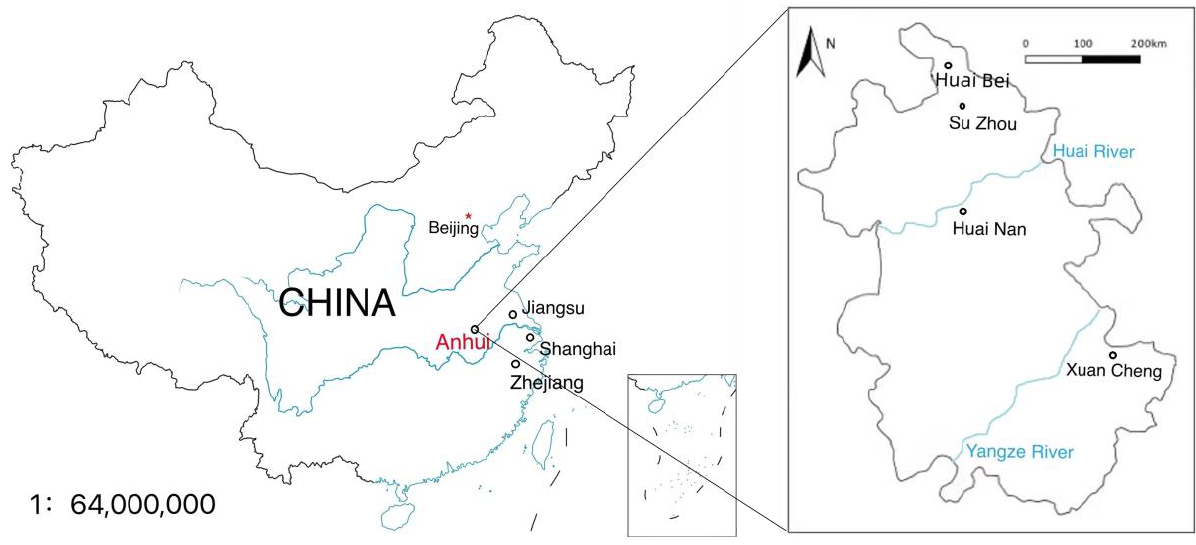
Figure 1. Sampling map. Table 1. The basic information for the Cupsful gas and APCD conditions and flue gas.